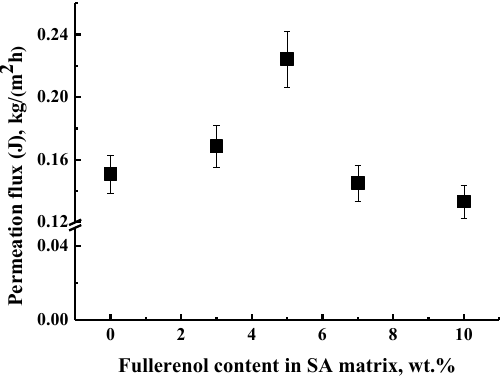
Figure 3. The dependence of permeation flux on fullerenol content in the SA membrane in pervaporation of azeotropic water (12 wt %)—isopropanol (88 wt %) mixture at 22 °C. Water content in the permeate for all membranes was 99.99 wt %.